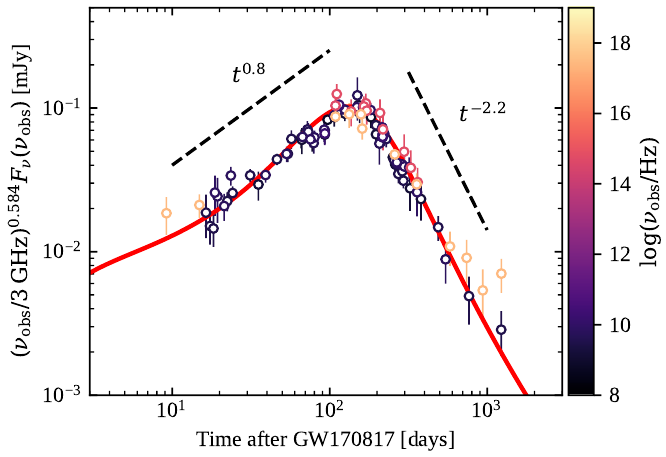
Figure 11. Observations and model of the afterglow of GRB170817A. Colored circles with error bars show flux densities measured in radio, X-ray and optical observations (data from [289]) at the position of GW170817, rescaled to a common frequency of 3 GHz assuming a power-law spectrum F ν ∝ ν − 0.584 [60]. The data points are color-coded according to the color bar on the right in order to show the original observing frequency. The red solid line is the prediction of an off-axis structured jet model with a power-law profile of both the energy and the Lorentz factor, with the same form and similar parameters as that in [67], namely E ( θ ) = E ( 0 ) / ( 1 + ( θ / θ c ) s E ) and Γ ( θ ) = 1 + ( Γ ( 0 ) − 1 ) / ( 1 + ( θ / θ c ) s Γ ) with θ c = 3.2 ◦ , E ( 0 ) = 4 × 10 52 erg, s E = 4.5, Γ ( 0 ) = 1000, s Γ = 3.3, n = 10 − 3 cm − 3 , (cid:101) e = 0.1, (cid:101) B = 10 − 4 , p = 2.168 and θ v = 19 ◦